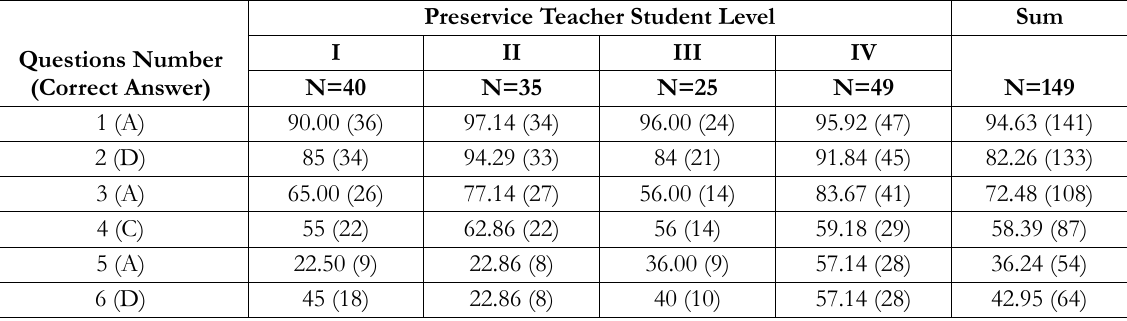
Table 3. Percentage of preservice teachers’ answers correctly in the first tier (questions 1, 3, and